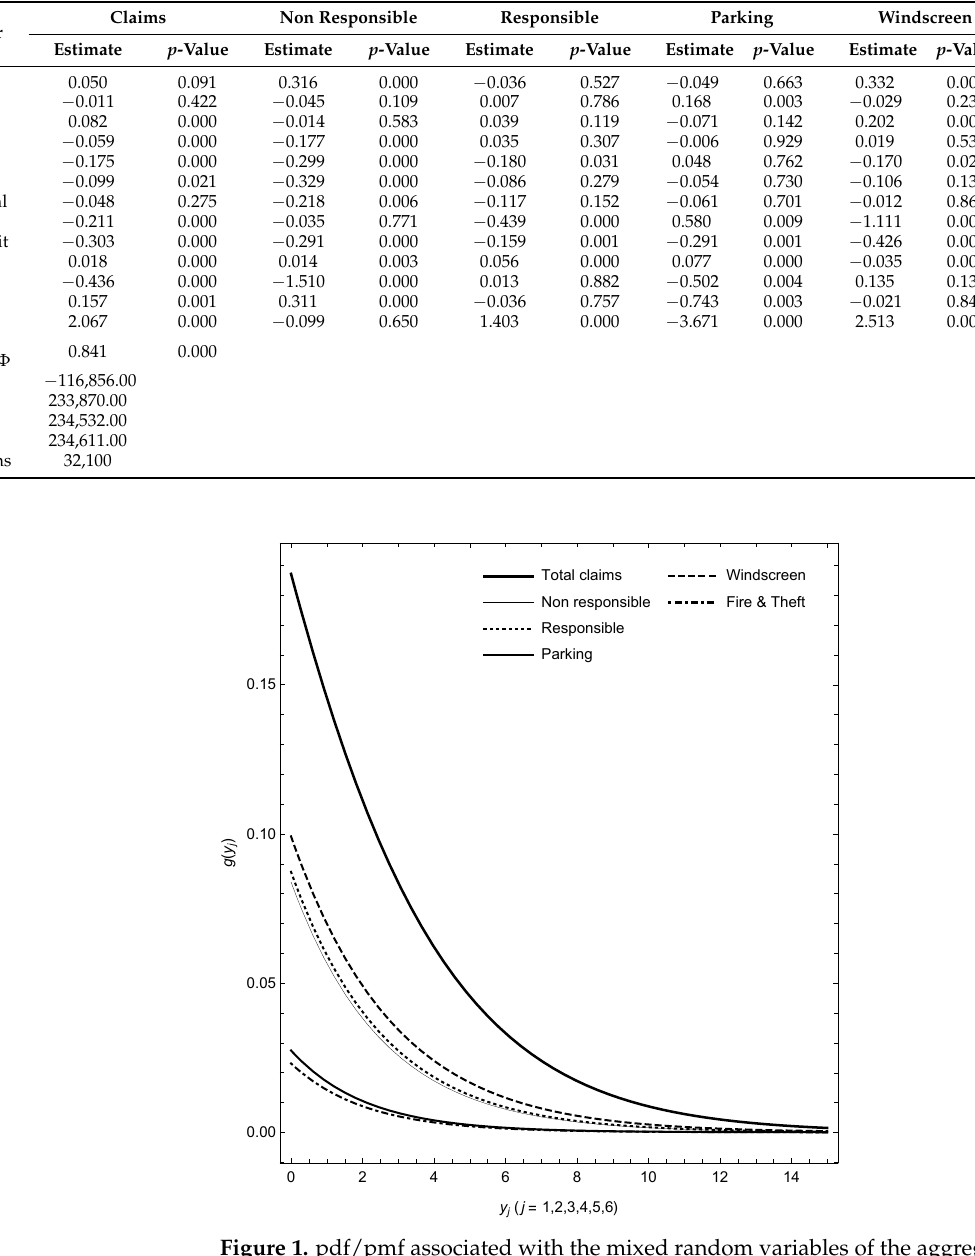
Figure 1. pdf/pmf associated with the mixed random variables of the aggregate claims amount for Claims ( Y 1 ) and the different coverages ( Y 2 , . . . , Y 6 ) obtained from the estimated value of the mean of the claims size, (cid:98) σ =